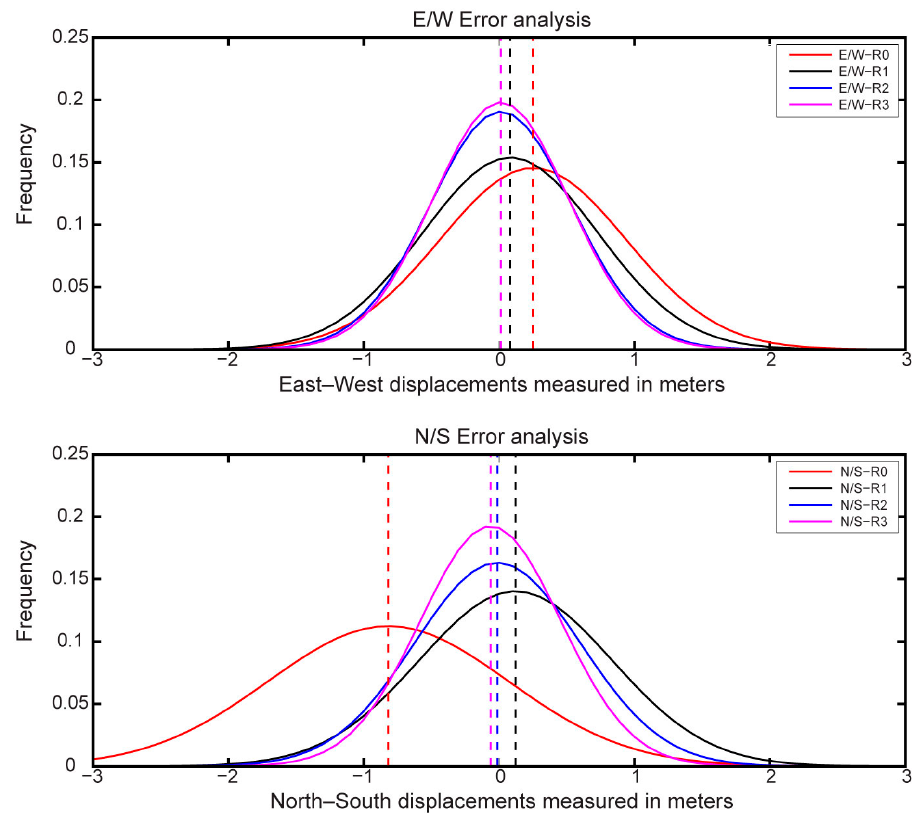
Figure 12. Histograms of the process results R0, R1, R2, and R3 in the selected area. The histograms are shown as below: original COSI-Corr process result (R0, red line), result after removing orbital error (R1, black line), result after removing SA and attitude jitter distortions (R2, blue line), and result after removing TSA (R3, pink line). The vertical dotted lines represent the relevant mean (location) of histogram curves in the same color.